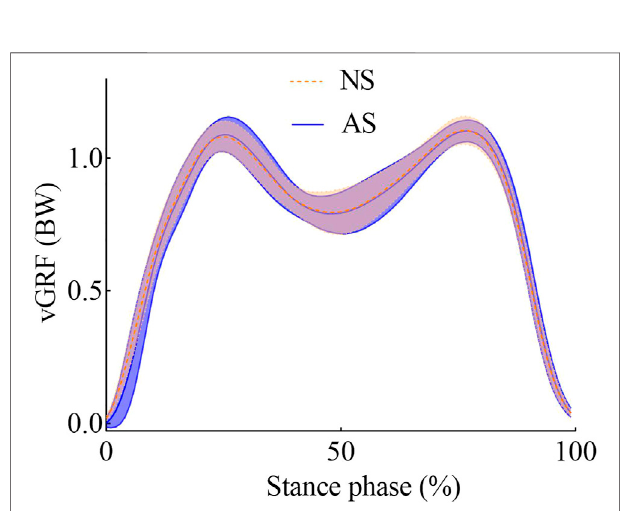
FIGURE 1 | Scheme of shoe conditions. (A) Schematic illustration of NS. (B) Schematic illustration of AS. (C) Prototype of AS.